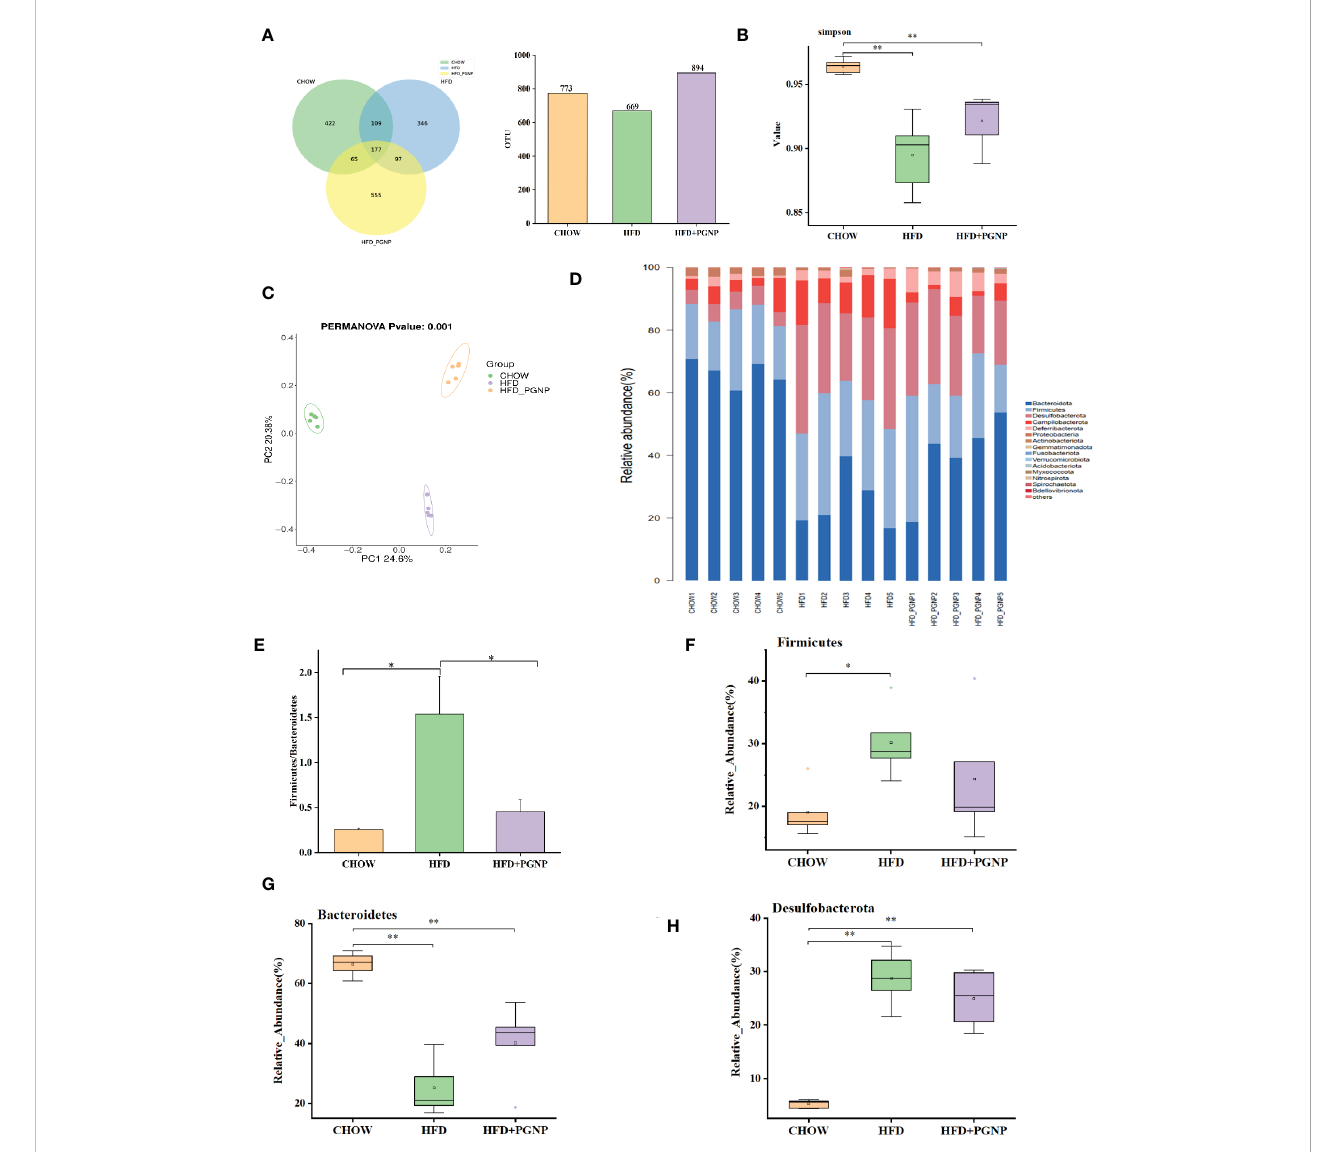
FIGURE 4 Effects of PGNP on gut microbial dysbiosis in HFD-fed mice ( n =5). Venn graph of the OTUs from gut microbiota of the Chow (green), HFD (blue), and HFD + PGNP(yellow) groups (A) . Simpson index (B) . Weighted UniFrac PCoA of gut microbiota based on the OTU data of three groups (C) . The component of gut microbiota at the phylum level (D) . Firmicutes/Bacteroidetes abundance ratio in faecal microbiota in Chow, HFD, and HFD + PGNP groups (E) . Relative abundance of Firmicutes (F) . Relative abundance of Bacteroidetes (G) . Relative abundance of Desulfobacterota (H) . ** P < 0.01, * P <